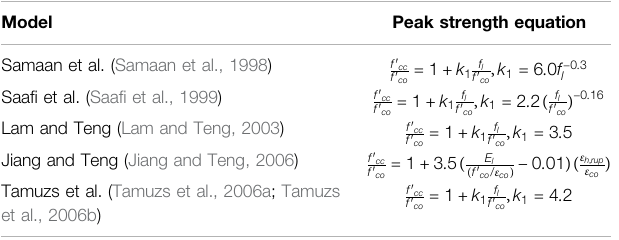
TABLE 7 | Summary of the models used to predict peak axial strength of test specimens.